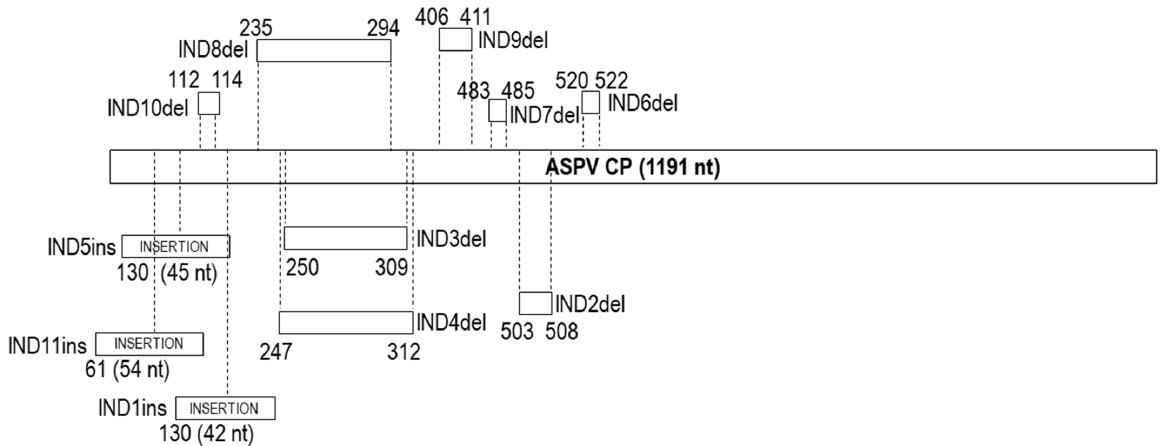
Figure 2. Schematic presentation for the localization of indels (designated as IND) identified in the ASPV CP gene of isolates used in this study. Indels type as deletions (marked as del) or insertions (marked as ins). Positions correspond compared to the 1191 nt CP size reference gene .